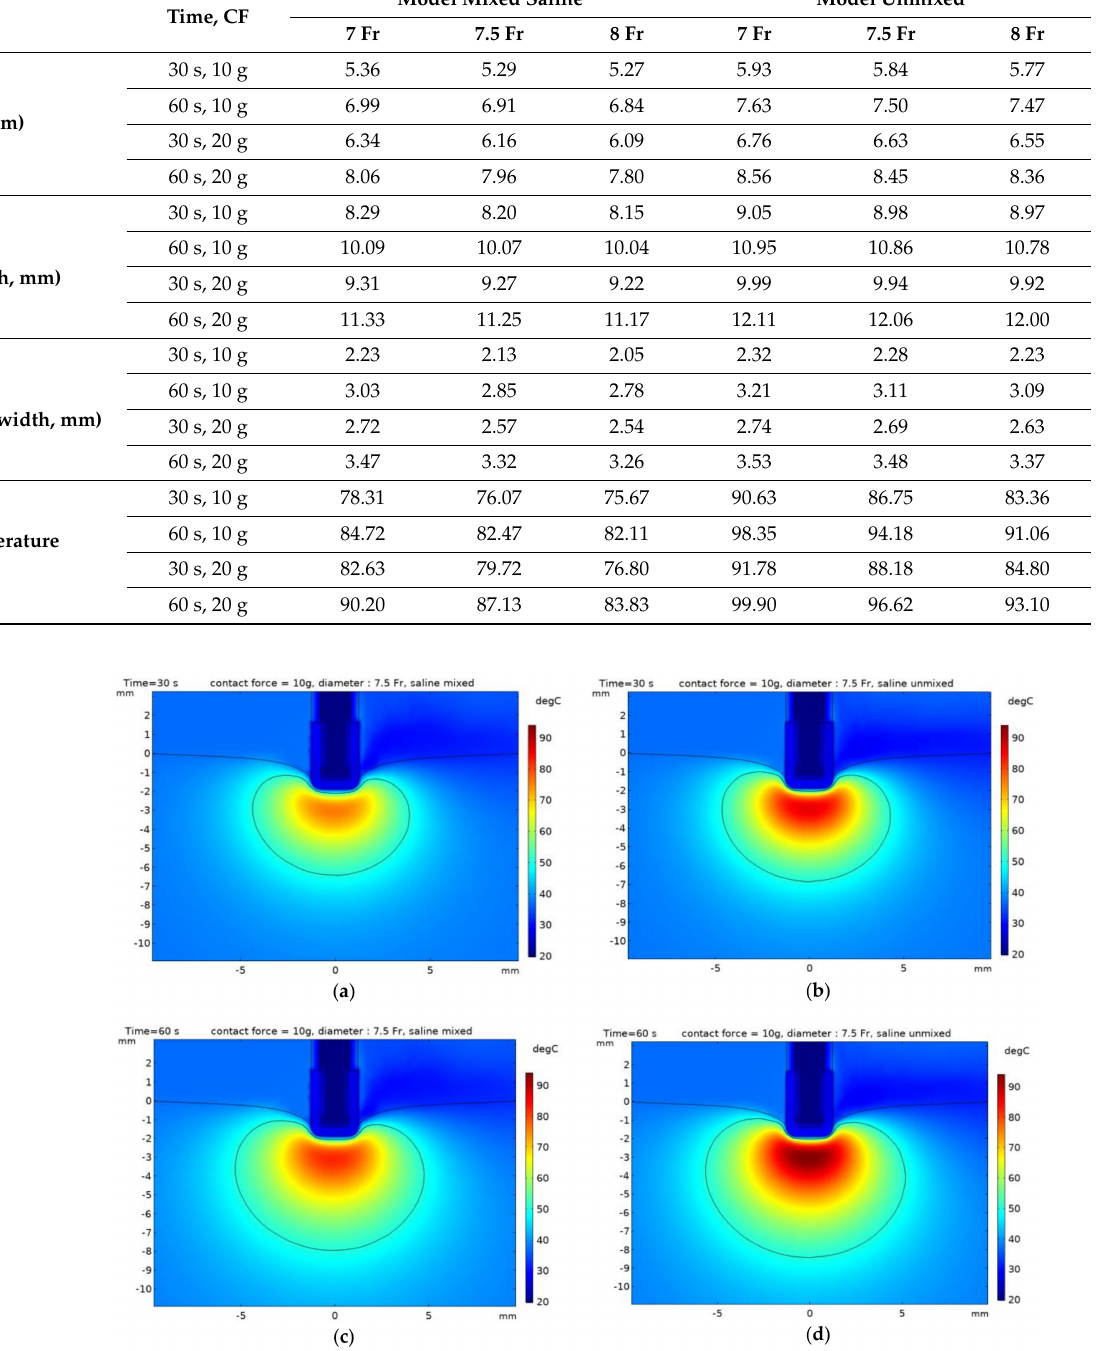
Figure 9. Temperature distribution with contour 50 ◦ C of the heart tissue with the catheter diameter of 7.5 Fr and contact force of 10 g. ( a , b ) time: 30 s, ( c , d ) time: 60 s, ( a , c ) model mixed saline, ( b , d ) model